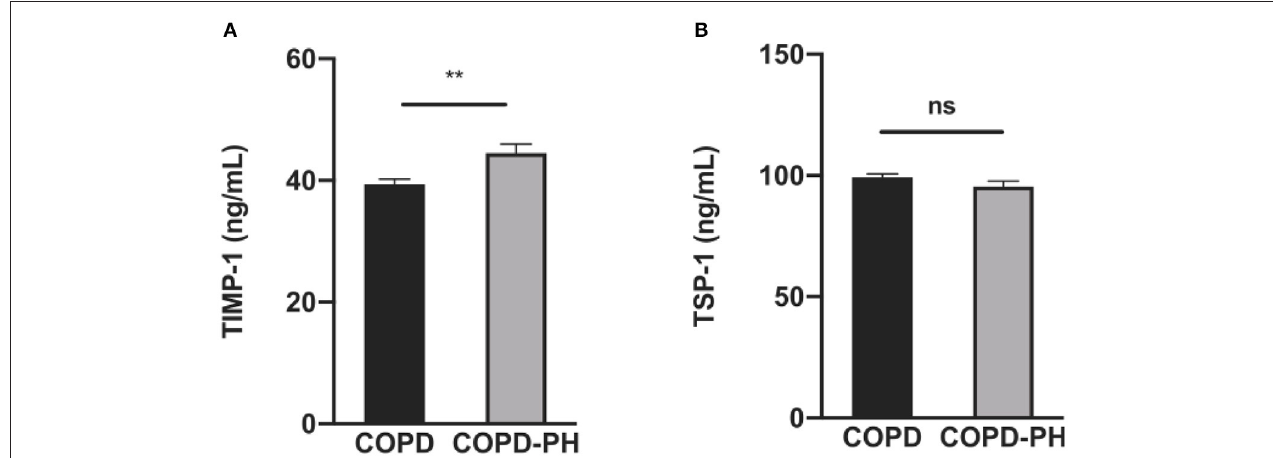
FIGURE 2 | The results of TIMP-1 (A) and TSP-1 (B) between COPD and COPD-PH group in validation cohort by ELISA. The P -value of each factor was obtained from unpaired Student’s t -test analysis. ** P < 0.01 vs. COPD group; ns, no significant statistical difference.